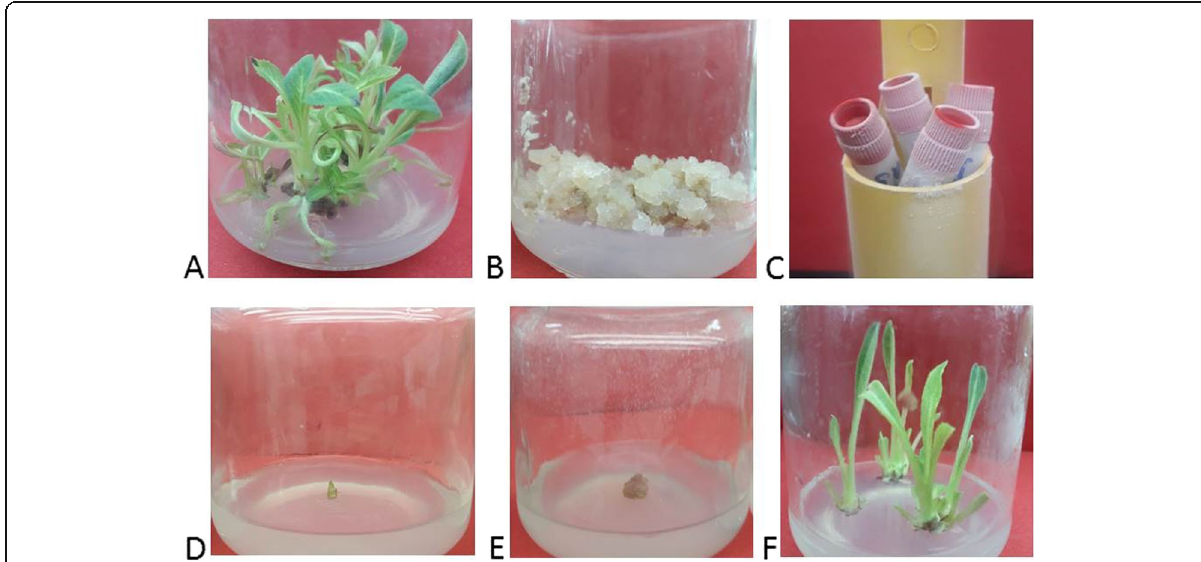
Fig. 1 Shootlets of globe artichoke grown on MS medium supplemented with 1 mg/l BA ( a ), callus cultures were initiated from leaf explants and maintained on MS medium amended with 0.1 mg/l NAA, 0.5 mg/l 2,4-D, and 0.5 mg/l kin ( b ). Cryotubes taken from liquid nitrogen container ( c ), cryopreserved shoot apices grown on MS medium + 1 mg/l BA ( d ), cryopreserved callus inoculum transferred onto MS medium + 0.1 mg/l NAA, 0.5 mg/l 2,4-D, and 0.5 mg/l kin ( e ) and shootlets developed from cryopreserved shoot apices after 12 weeks of culturing on the recovery medium ( f